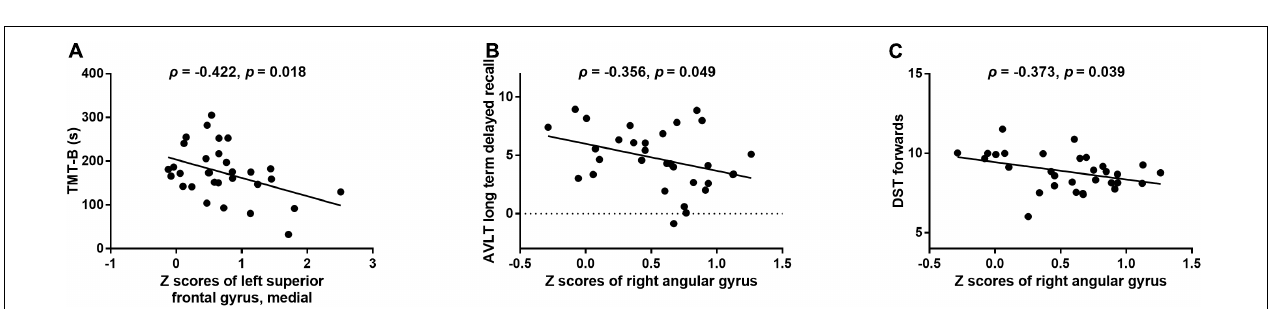
FIGURE 3 | FCD maps of inter-group comparisons. (A) The distribution of brain regions with changed FCD in the T2DM group. (B) The comparison of FCD z scores between the T2DM group and HC group. Gaussian random-field theory corrected (voxel p = 0.01, cluster p < 0.05). Color scale denotes the t -value. Error bars define the standard error of the mean. L, left; R, right.